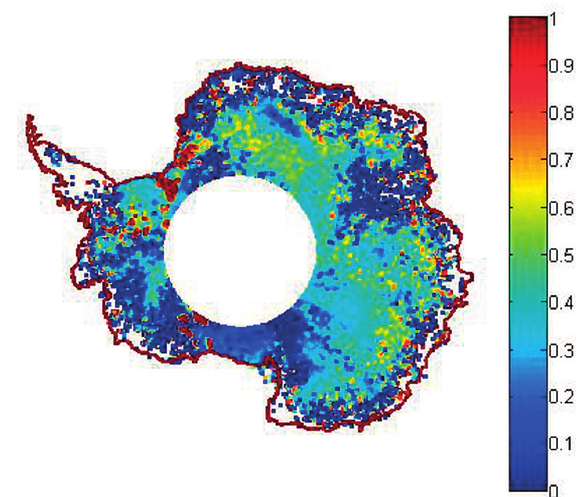
Figure 10. Portion of the leading edge width in hundredth of the leading edge width derived from ENVISAT we have to keep to correct the height